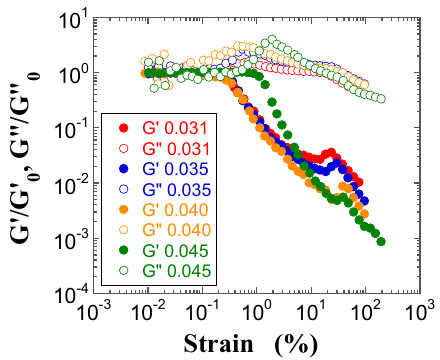
Figure 12. Double-logarithmic plots of G'/G' 0 (filled circles) and G” / G” 0 (open circles) for the PS suspensions at ϕ = 0.031 (red), 0.035 (red), 0.040 (orange), and 0.045 (green) as a function of strain.